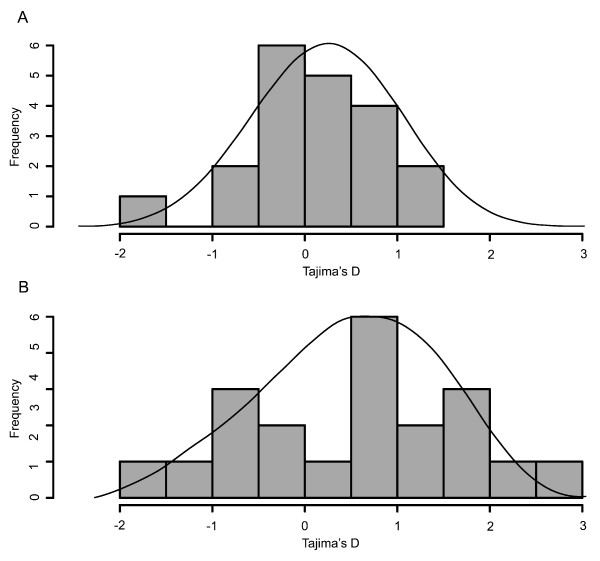
Observed values (bars) of Tajima's D for 20 X chromosome loci in (A) Biaka pygmies and (B) Melanesians compared to simulated distributions for each population (curves). Tajima's D values for the majority of empirical loci are consistent with simulated distributions that are obtained from an isolation-with-migration model parameterized with the inferred demography of these two populations.